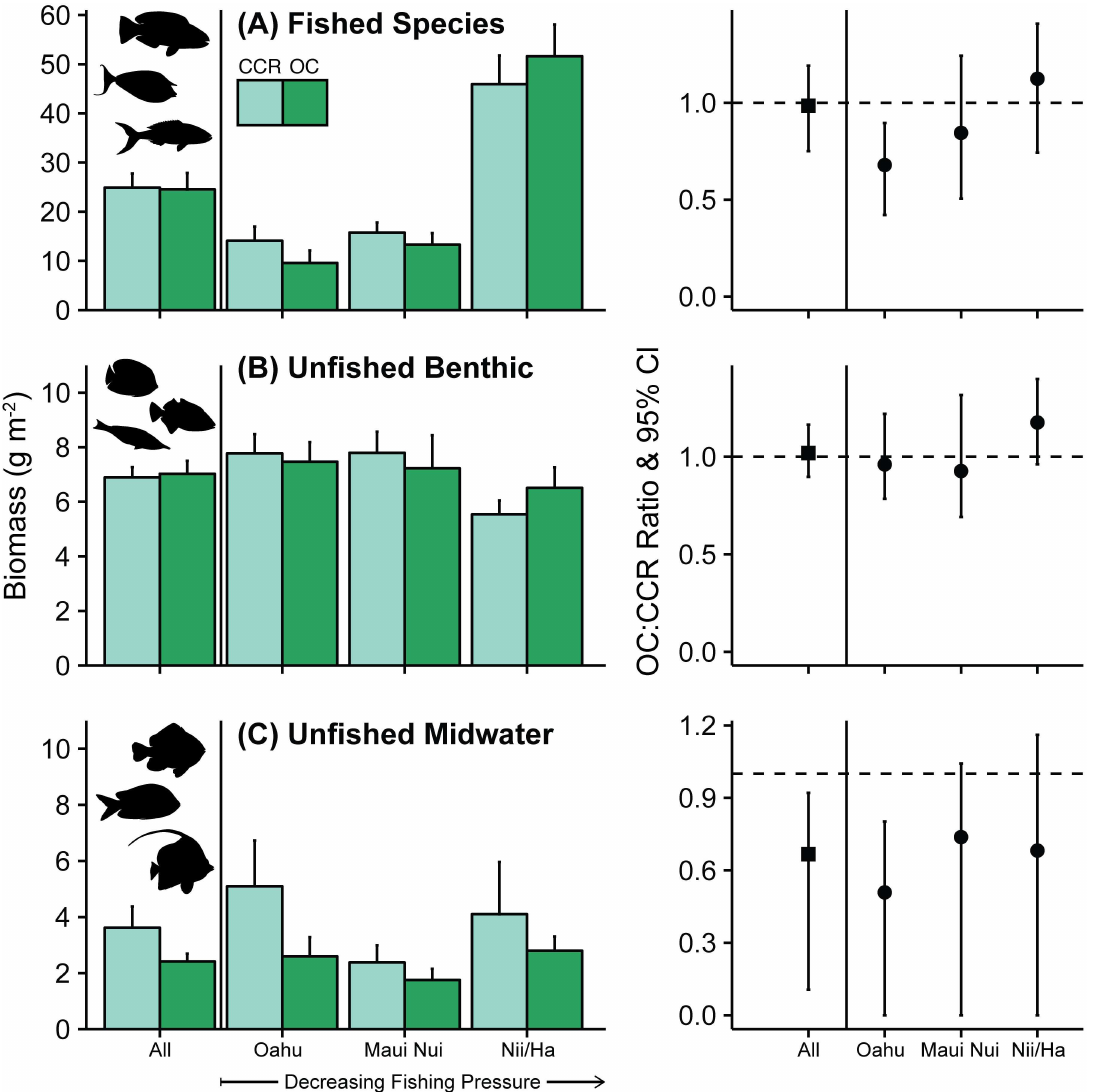
Fig 2. Fished and Unfished Biomass. Fished species (cid:21) 20 cm TL (except A . triostegus and C . strigosus (cid:21) 15 cm). Biomass boxplot with error bars indicatingstandarderror for all sites and for Oahu, Maui Nui and Nii-Hama (Niihauand Hamakua coast). Location groupsare orderedin direction of presumeddecliningspearfishing pressure from Oahu (highest) to Niihau-Hamakua (lowest). OC:CCR biomass ratio has 95% confidenceinterval for each location.